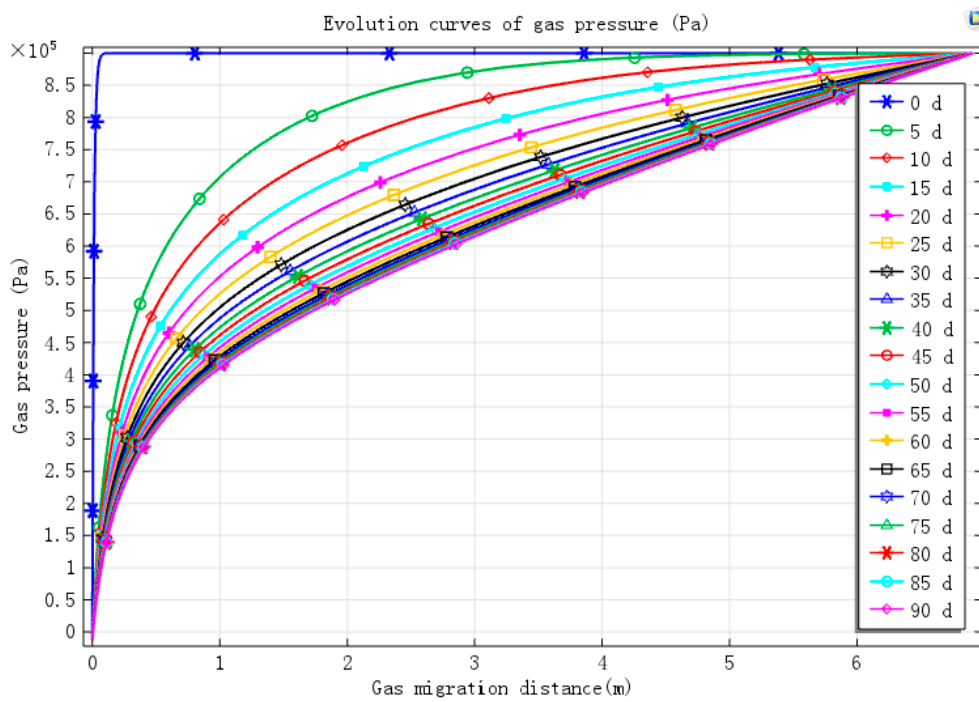
Figure 7. Evolution curves of gas pressure.